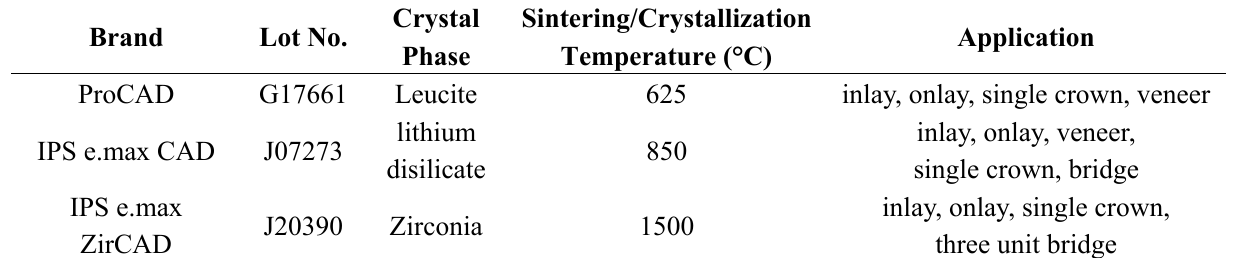
Table 1. Characteristics and applications of three all-ceramic dental restorations used in this